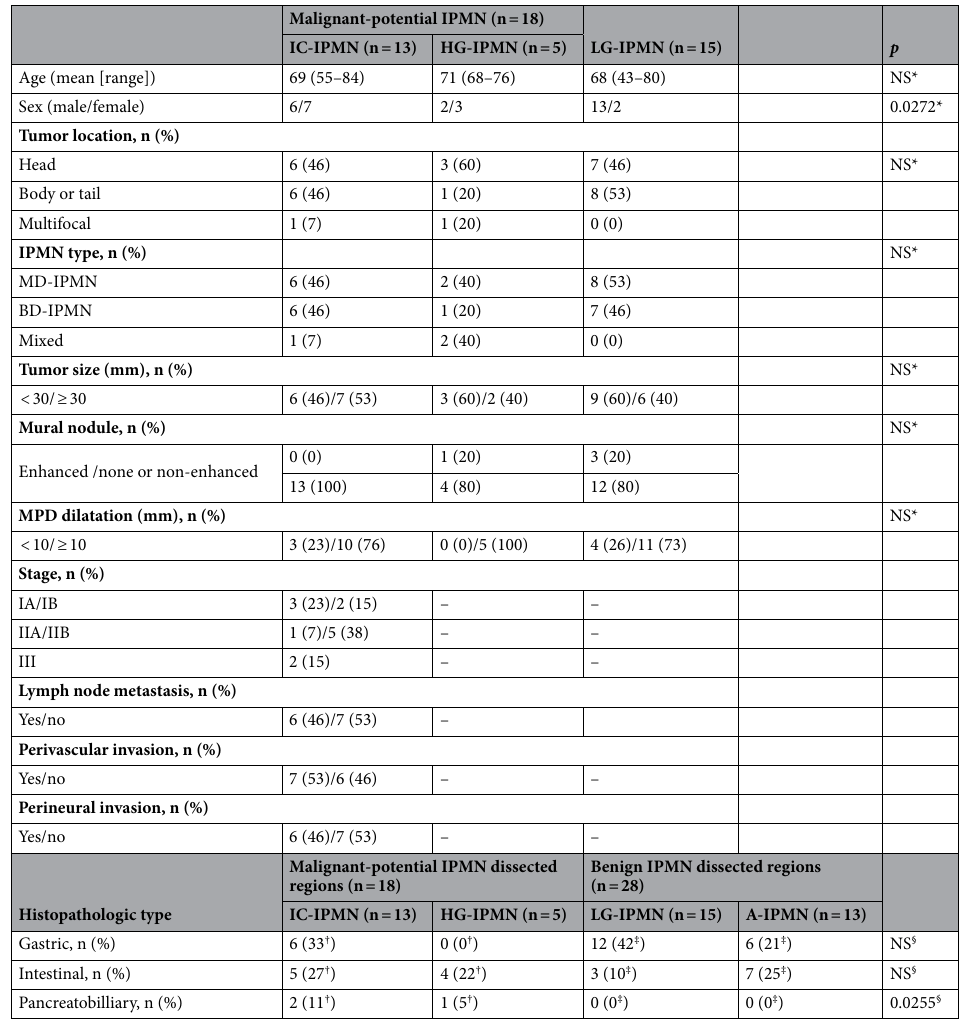
Table 1. Patient characteristics. MD-IPMN main duct IPMN, BD-IPMN branch duct IPMN. * p -value for comparisons of malignant-potential IPMN and LG-IPMN. † Proportions among malignant-potential IPMN dissected regions. ‡ Proportions among benign dissected regions. § p -value for comparisons among malignant- potential IPMN (IC-IPMN and HG-IPMN) and benign IPMN (LG-IPMN and A-IPMN) dissected